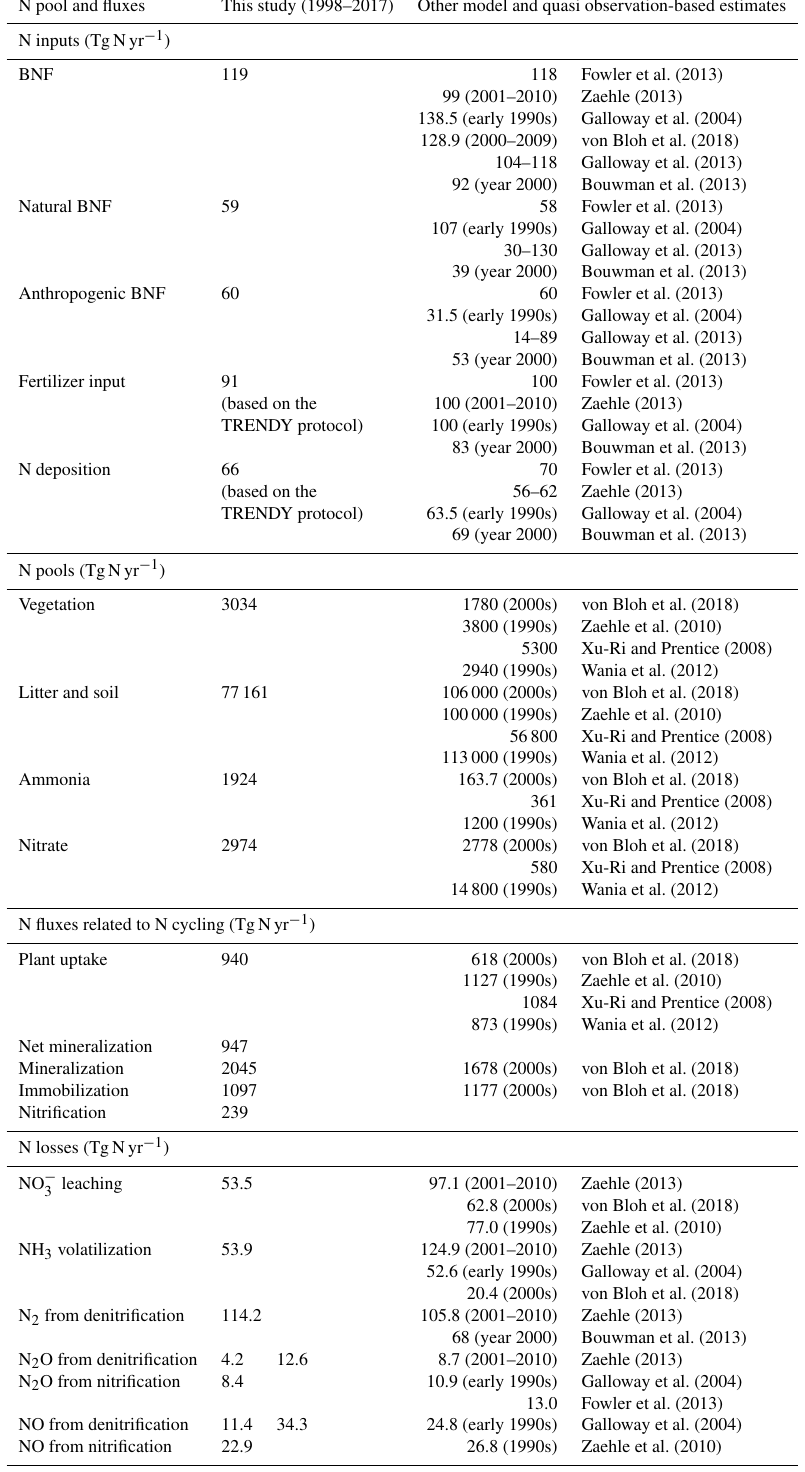
Table 2. Comparison of simulated global N pools and fluxes, from the FULL simulation, with other modelling and quasi observation-based studies (references for which are noted in the table). The time periods to which the other modelling and quasi observation-based estimates correspond are also noted, where available. The estimates are for land. The simulated fluxes and pool correspond to the period 1997–2018. In the last few rows, the simulated N 2 O and NO emissions from denitrification and nitrification are reported separately but also as their combined total. For these N 2 O and NO emissions, it is the combined total that must be compared to other